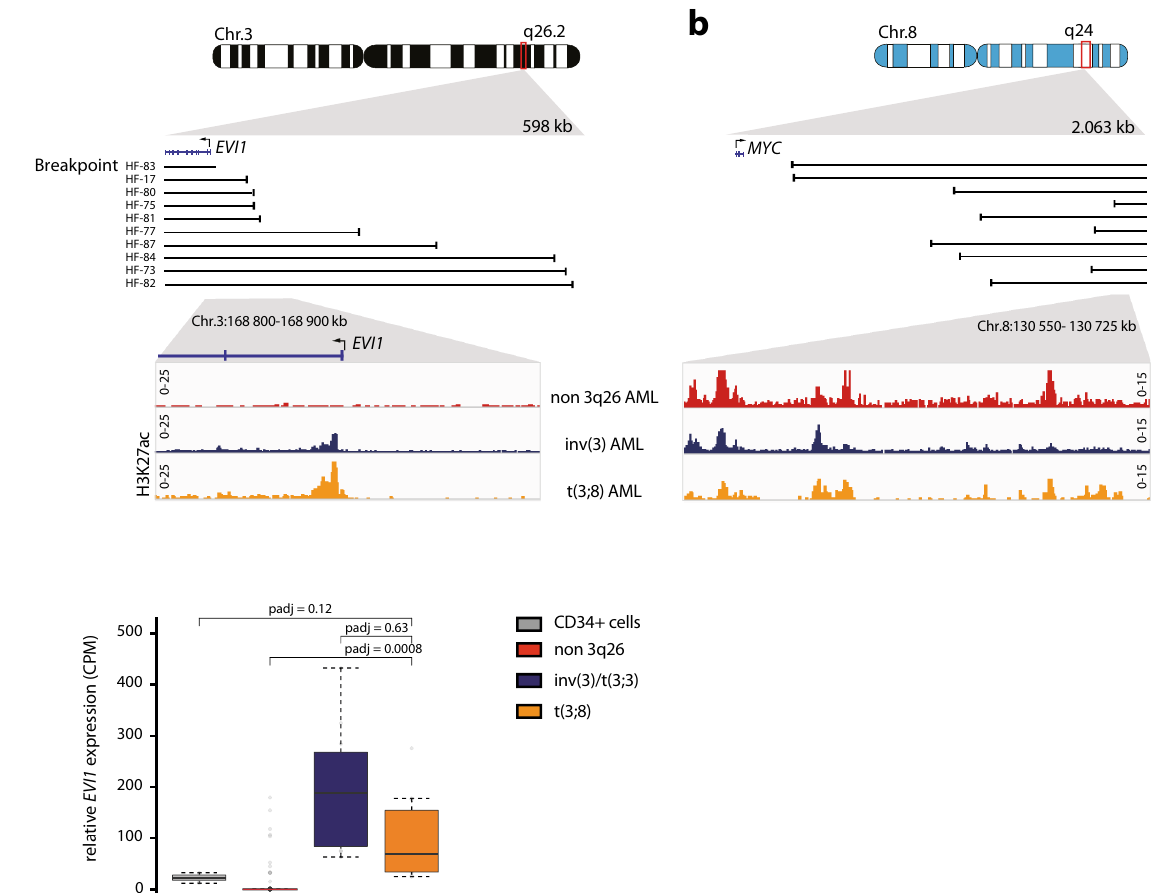
Fig. 1 MYC super-enhancer translocation and EVI1 overexpression in t(3;8)(q26;q24) AML. a Upper part, schematic depiction of Chr.3, zoomed in on 3q26.2. Black lines correspond to sample-speci fi c breakpoints detected by 3q-seq for each indicated t(3;8)(q26;q24) patient. Lower part: zoom-in on the EVI1 promoter, H3K27ac ChIP-seq data for a primary non-3q26 AML sample in red ( N = 1, AML-185), an inv(3)(q21q26) in blue ( N = 1, AML-2190) and a t(3;8)(q26;q24) in orange ( N = 1, AML-17). b Similar to A, but here in the upper part a schematic depiction of Chr.8, zoomed in on 8q24. Lower part: H3K27ac ChIP-seq data as in a , but here is a zoom-in on the + 1.7 Mb MYC super-enhancer. c EVI1 expression measured by RNA-seq in counts per million (CPM) for normal CD34 + HSPCs ( N = 9, gray), non-3q26 AMLs ( N = 114, red), inv(3)/t(3;3)(q21;q26) AMLs ( N = 11, blue), and t(3;8)(q26;q24) AMLs ( N = 10, orange). The lower and upper edges of the boxplots represent the fi rst and third quartiles, respectively, the horizontal line inside the box indicates the median. The whiskers extend to the most extreme values within the range comprised between the median and 1.5 times the interquartile range. The circles represent outliers outside this range. The statistical signi fi cance of the comparisons between these groups was determined by the Wald test in the DESeq2 package. Adjusted p -values (padj) following multiple testing corrections by the Benjamini – Hochberg procedure are